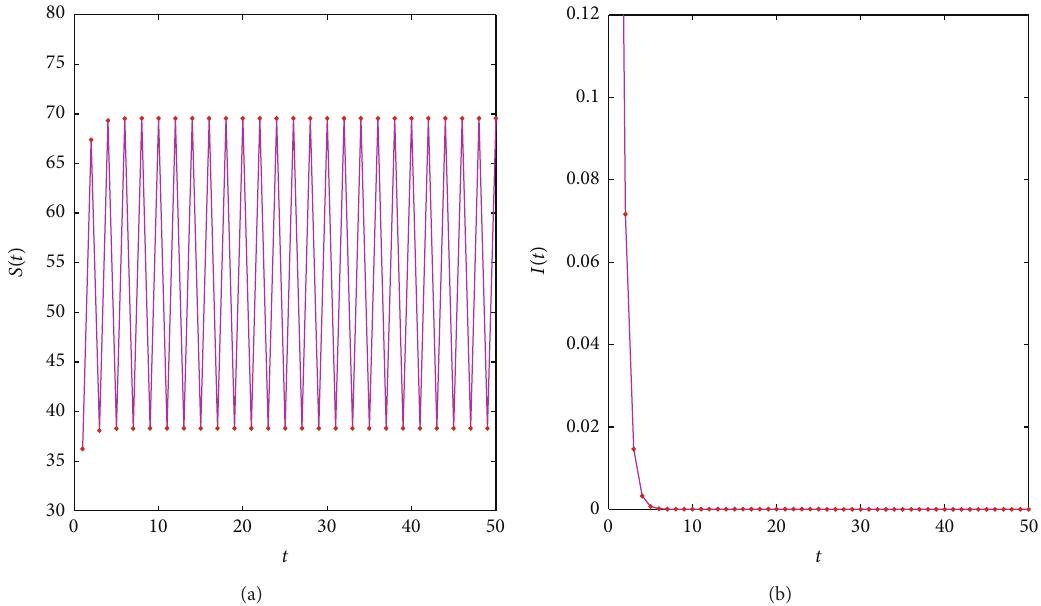
Figure 3: Dynamical behavior of system (2) with 𝛽(𝑡) = 0.005( sin 𝑡+2) , 𝜆(𝑡) = 10 , 𝛼(𝑡) = 0.01 , 𝜇(𝑡) = 0.1 , 𝛾(𝑡) = 0.1 , 𝜀(𝑡) = 0.8 , 𝜔 = 2𝑇 = 2𝜋 , and 𝜃 1 = 𝜃 2 = 0.9 . (a) Time series of 𝑆(𝑡) . (b) Time series of 𝐼(𝑡) .